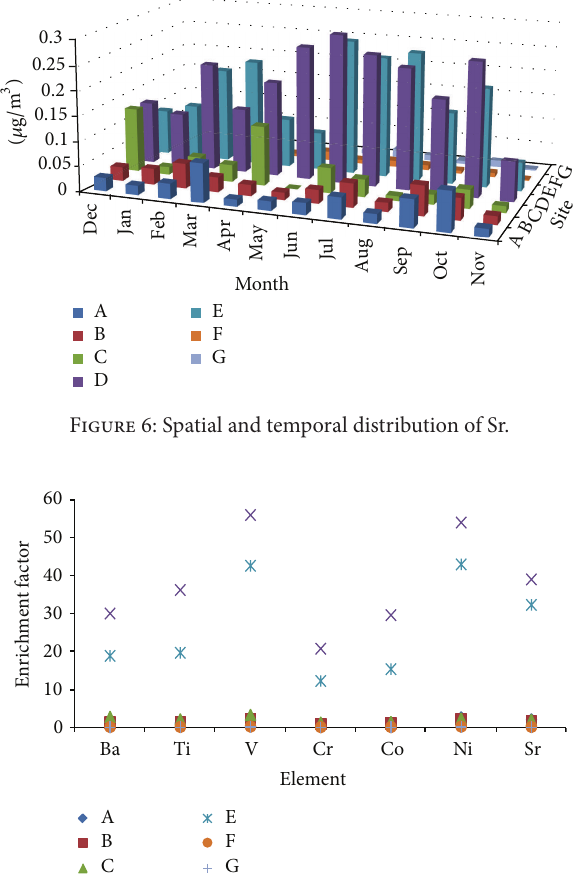
Figure 7: Enrichment factors of Ba, Ti, V, Cr, Co, Ni, and Sr at the 7 sampling sites.